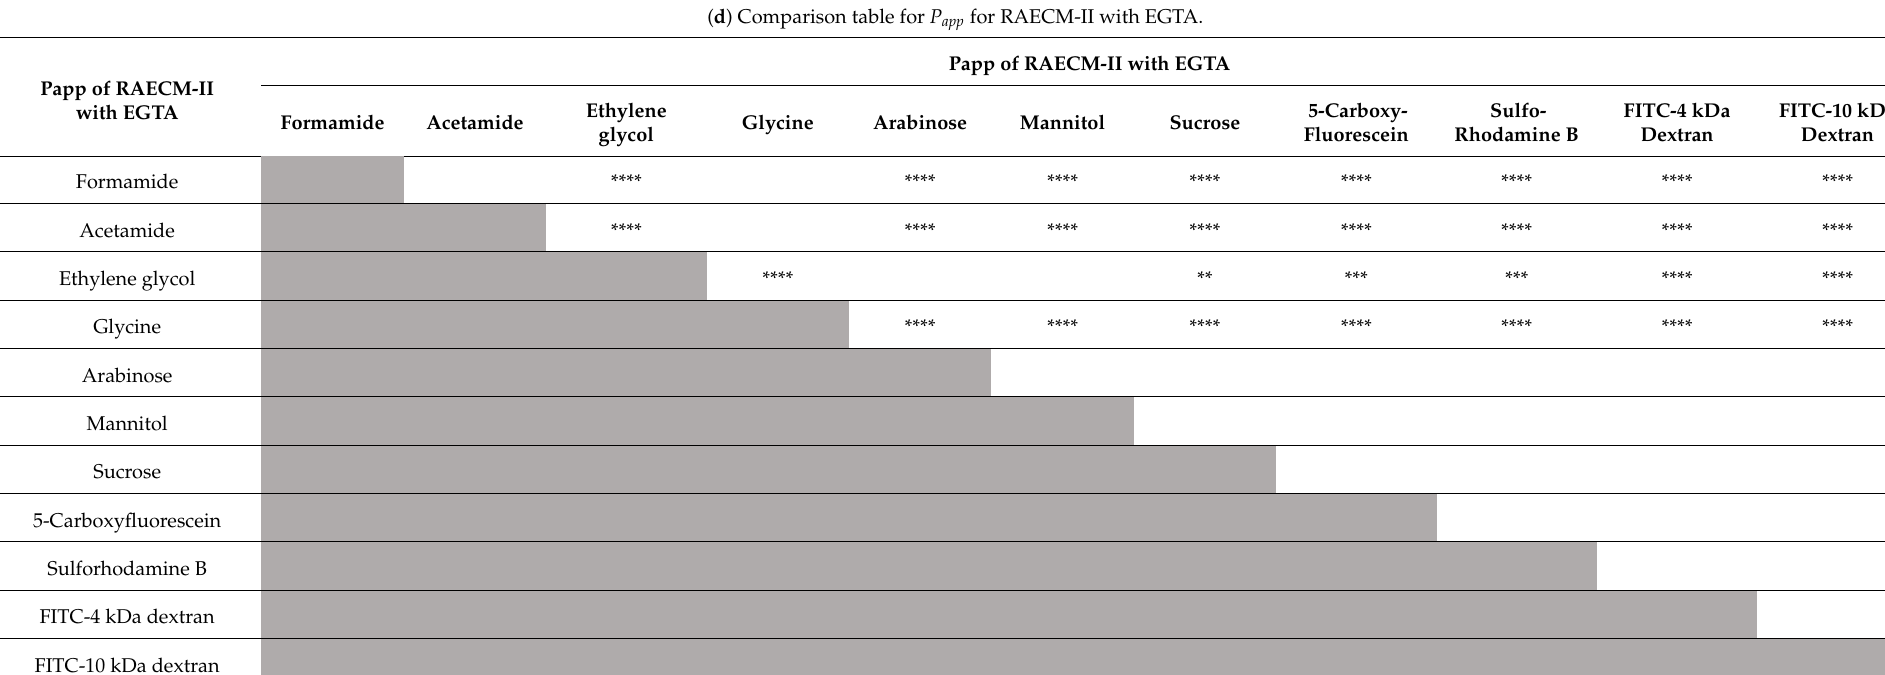
Table A1. Cont. ( d ) Comparison table for P app for RAECM-II with